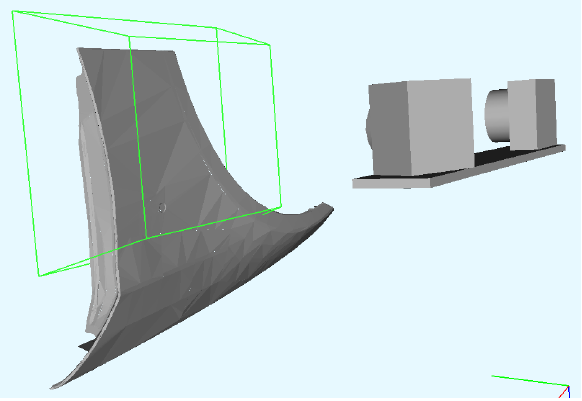
Figure 4. Modelling of the